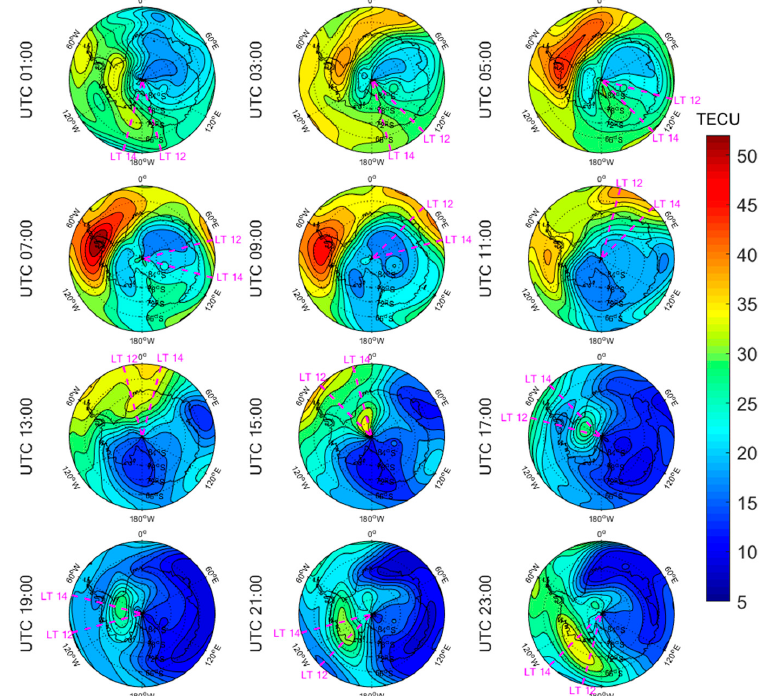
Figure 11. Spatial distribution of mapping TEC of 12 sections under high solar activity year, polar day (DOY 001 in 2014) over the Antarctic. The magenta lines in each subplot represent the longitudes at 12:00 and 14:00 at the middle of the 2 h section of the corresponding